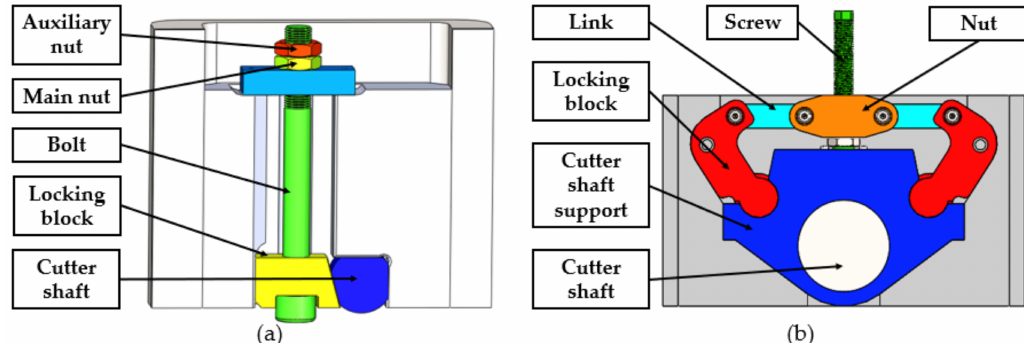
Figure 9. ( a ) Schematic diagram of the anti-loosening structure of the TCS; ( b ) Schematic diagram of the anti-looseness structure of the novel TBM